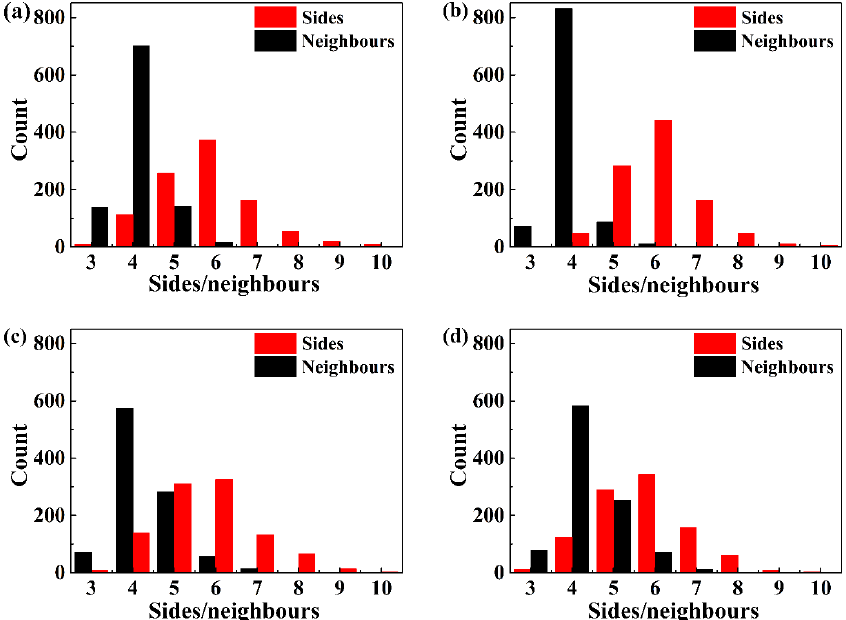
Fig. 19 Statistical histograms of the number of sides (black bars) and neighbors (red bars) for patterns in (a) TiO 2 , (b) La 0.5 Sr 0.5 CoO 3 , (c) La 2 Zr 2 O 7 , and (d) YSZ splats. Reproduced with permission from Ref. [116] for (a–c), ©